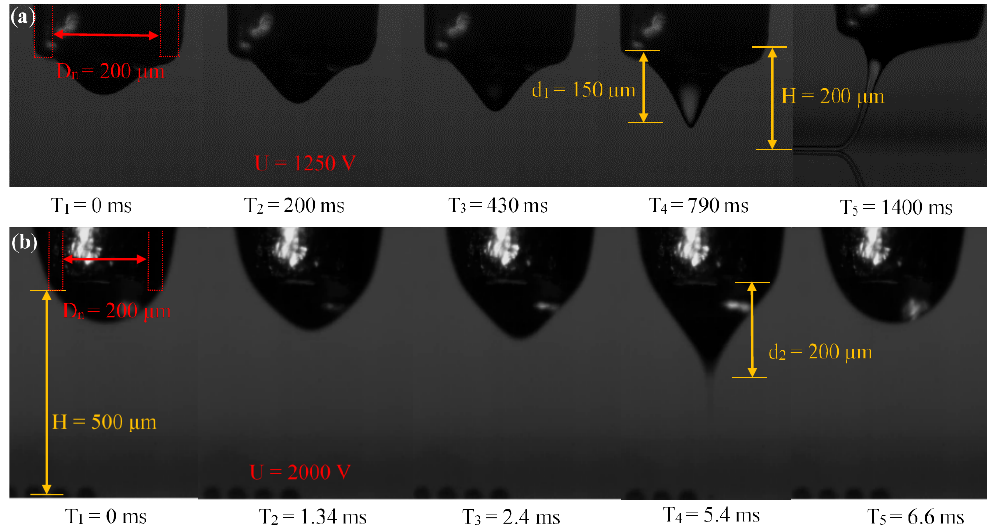
Figure 5. Cone jet deformation and deposition process: ( a ) high-viscosity material (PCL); ( b ) low- viscosity material